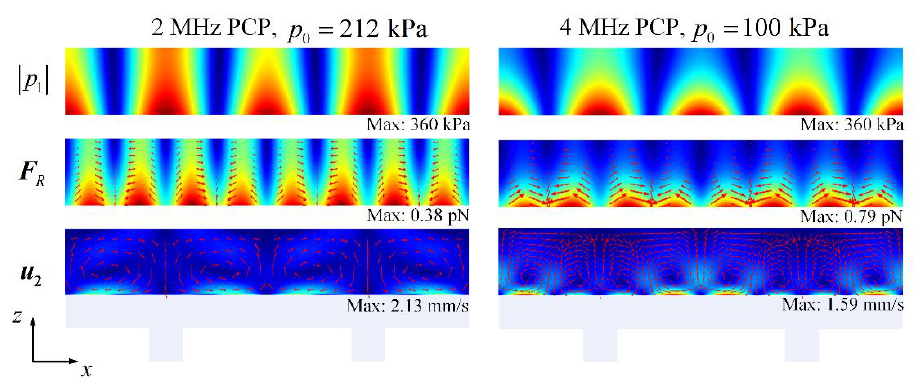
Figure 7. Distribution of the first-order acoustic field | p 1 | , acoustic radiation force field F R , and acoustic streaming field u 2 for PCPs with resonant frequencies of 2 and 4 MHz. The incident pressures p 0 are 212 and 100 kPa, respectively.